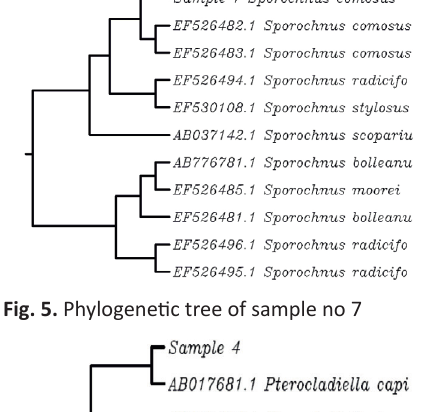
Fig. 5. Phylogenetic tree of sample no